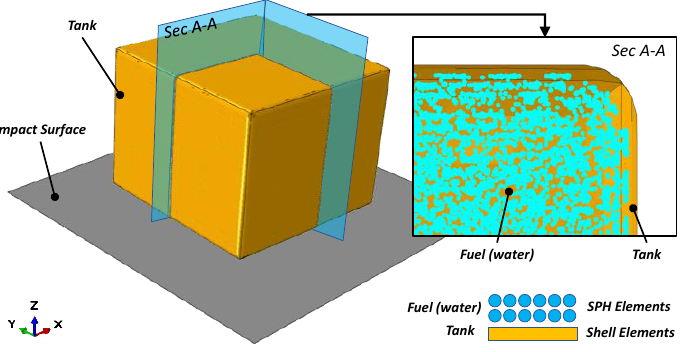
Figure 2. FE model. Figure 2. FE model.